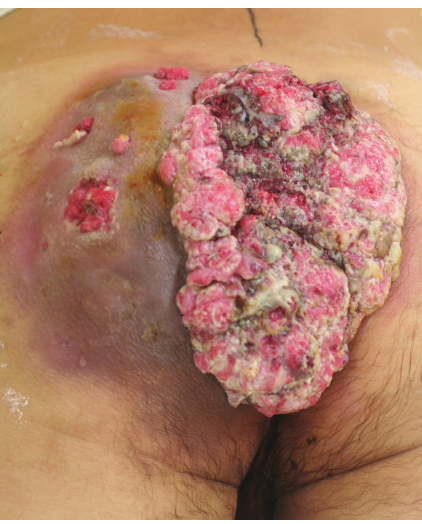
Figure 1: The mass on the left buttock was 20 × 10 × 4cm in diameter and its surface was cauliflower-shaped with profuse exudates and ulceration. The skin around the mass colored brownish to purplish and had ulcers likely penetrating to the mass.